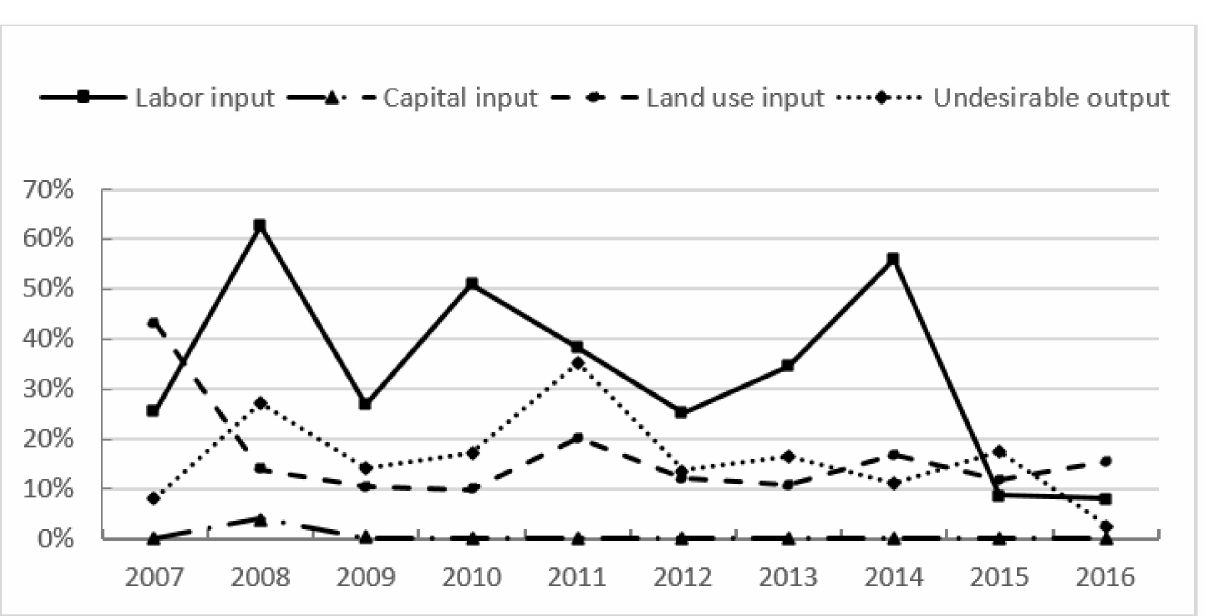
Figure 2. Changes of redundancy rate of the input and output variables in China’s mining